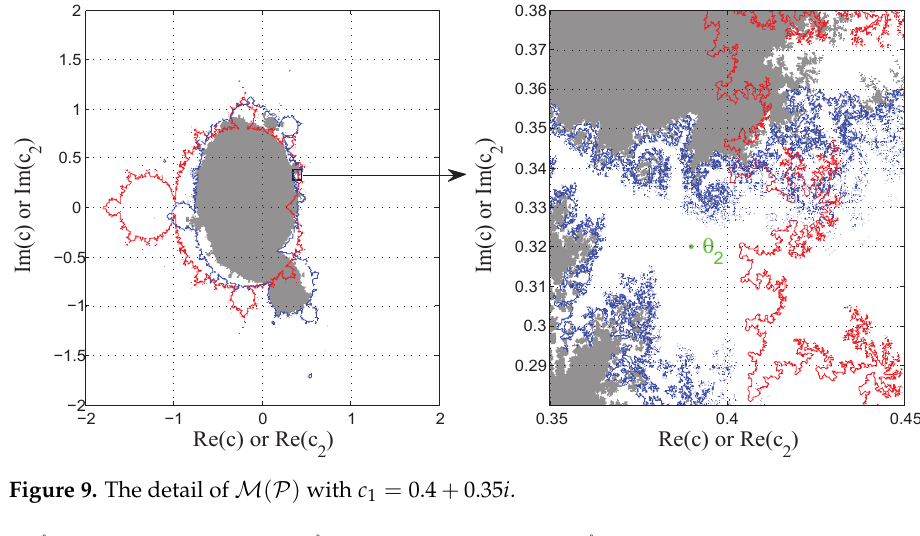
Figure 9. The detail of M ( P ) with c 1 = 0.4 + 0.35 i .